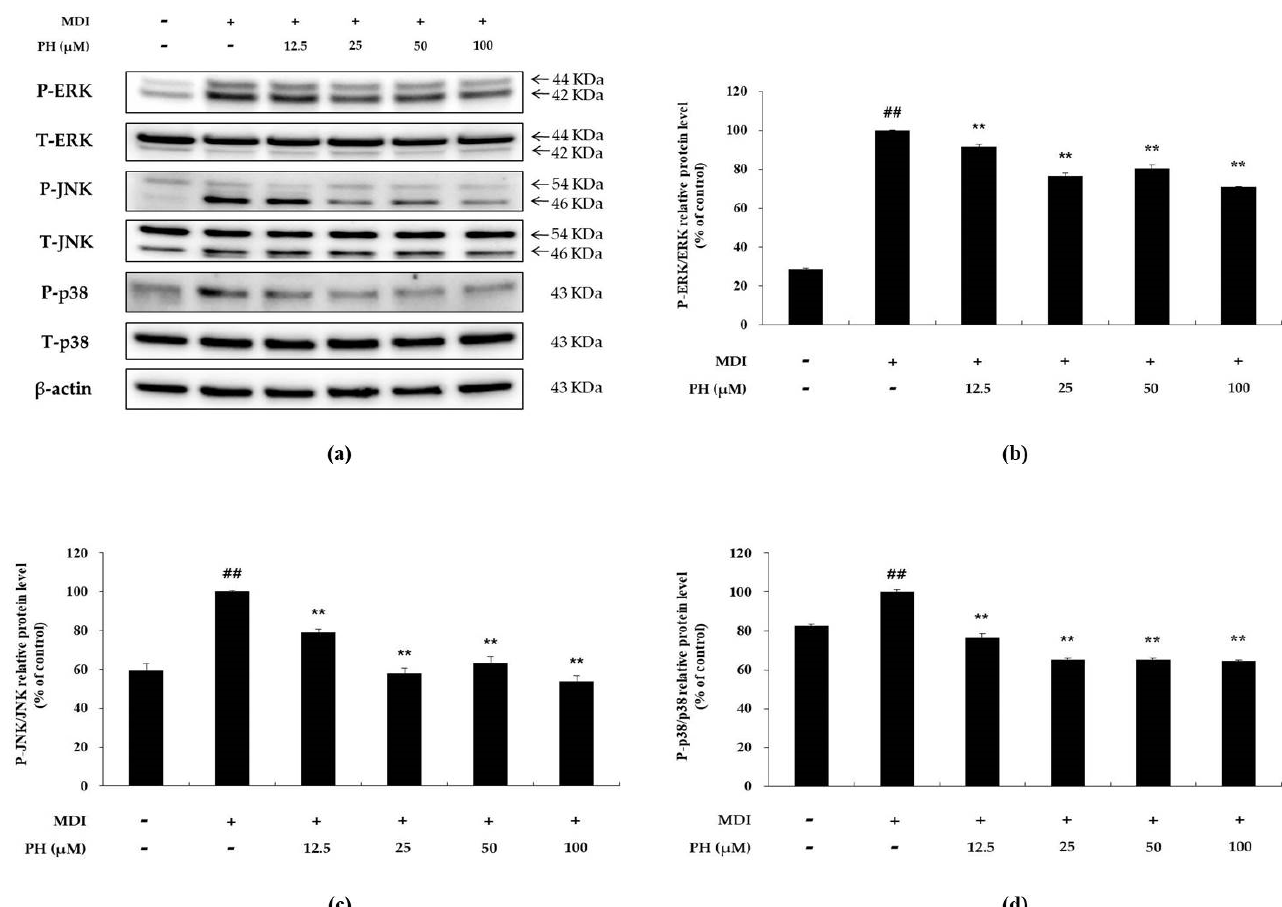
Figure 4. Effect of PH on the phosphorylation of MAPK. Adipocyte differentiation was induced in post-confluent cells using MDI differentiation medium, and the cells were treated with indicated concentrations of PH for 30 min. ( a ) The Western blot result of P-ERK/ERK, P-JNK/JNK, P-p38/p38, and β -actin in 3T3-L1 adipocytes. The relative protein levels of ( b ) P-ERK/ERK, ( c ) P-JNK/JNK, and ( d ) P-p38/p38 are presented as the mean ± standard deviation of three independent measurements using the ImageJ program. The results of the relative protein levels are expressed as percentages relative to the control cells treated with MDI alone. ** p < 0.01 indicates significant differences versus the MDI-only control. ## p < 0.01 indicates significant differences versus an untreated control.